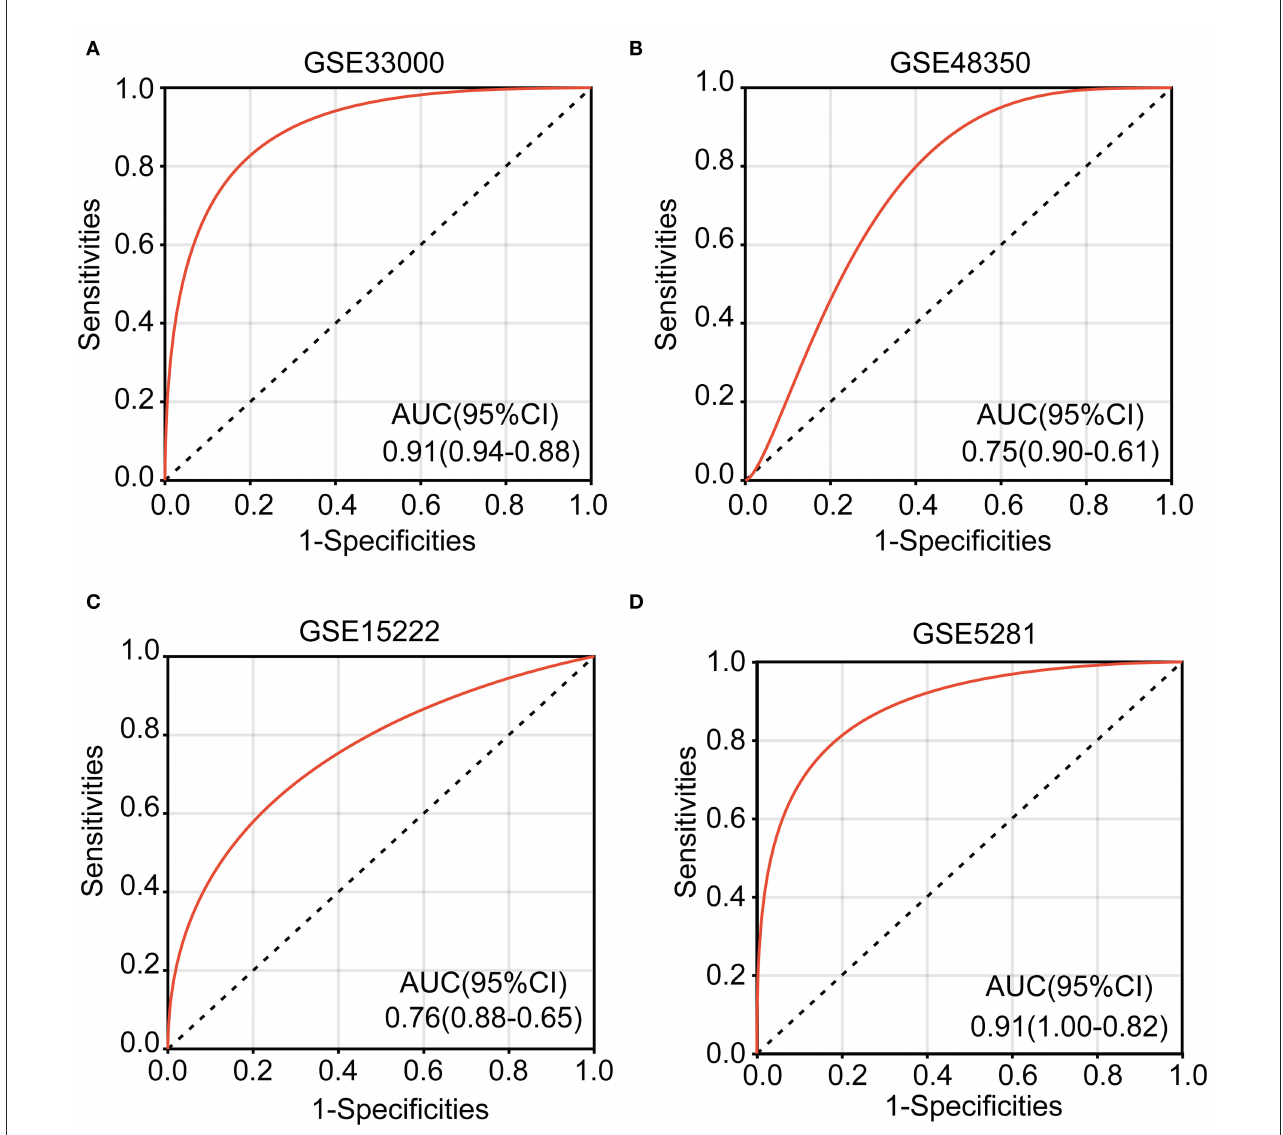
FIGURE7 Receiver operating characteristic (ROC) curves and corresponding AUC values for the four expression cohorts. (A) GSE33000, (B) GSE48350, (C) GSE15222, and (D)